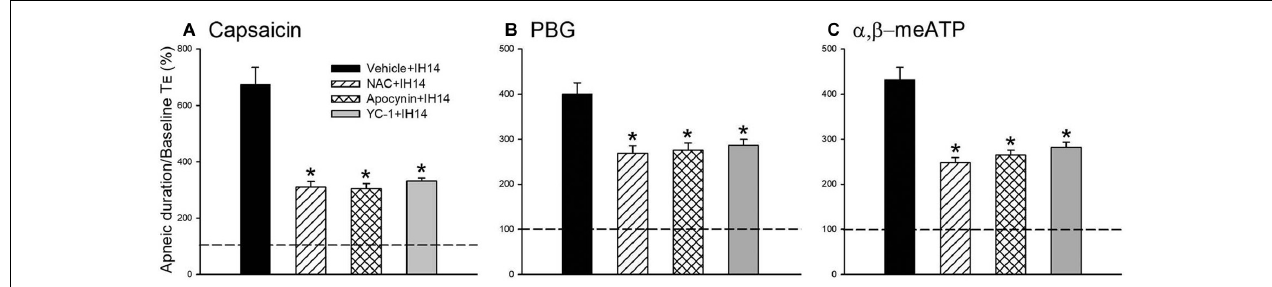
FIGURE 4 | Mean apneic responses to laryngeal provocation of capsaicin (A) , PBG (B) , and α , β -meATP (C) from four groups after exposure to IH for 14 days with daily intraperitoneal treatment with N-acetyl-L-cysteine (NAC, an antioxidant; NAC + IH14), apocynin (an inhibitor of NADPH oxidase; Apocynin + IH14), YC-1 (an inhibitor of HIF-1 α ; YC-1 + IH14) or their vehicle (Vehicle + IH14). Apneic responses are reflected by the apneic ratio, as explained in the legend of Figure 2 . Horizontal dashed lines indicate an apneic ratio of 1 (100%; no response). * p < 0.05 compared with Vehicle + IH14. Data in each group are the mean ± SE from 10 rats.